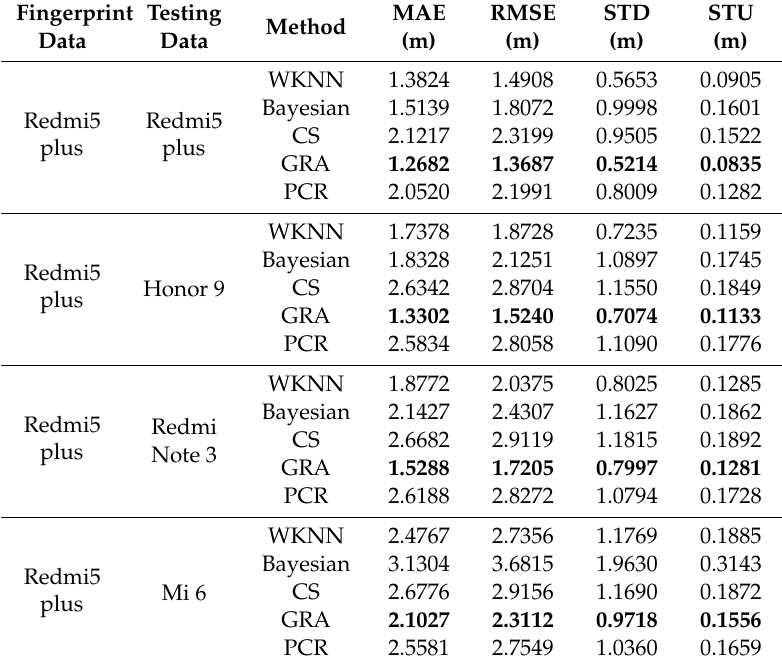
Table 3. Detailed positioning errors for different methods under heterogeneous and the same smartphones.